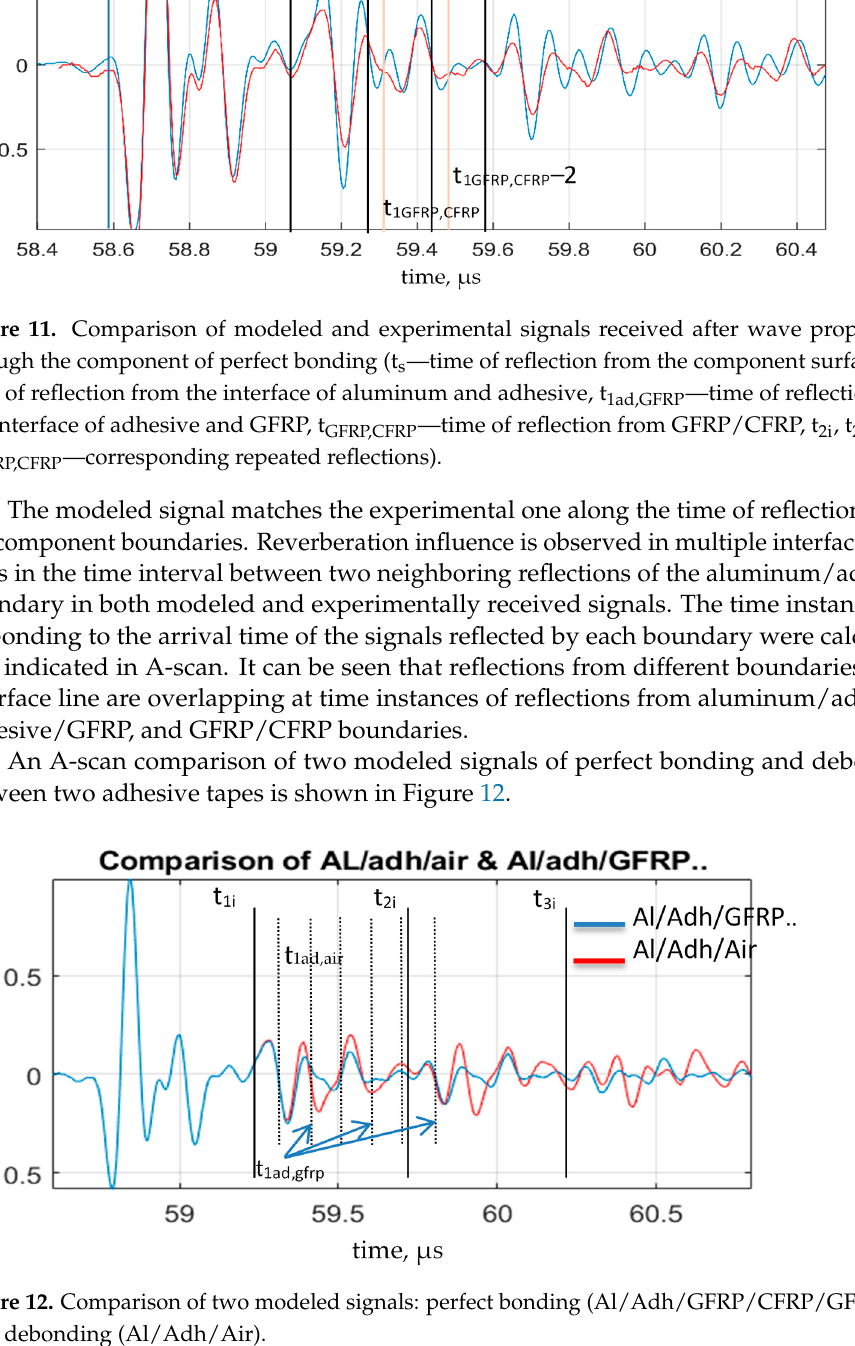
Table 5. Selected time intervals with significant change in amplitude.